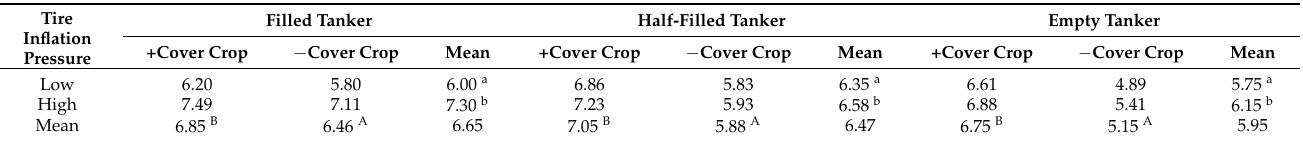
Table 3. Tire track depth (cm) affected by tire inflation pressure, filling level of slurry tanker (filled, half-filled and empty), and ground covering (+cover crop, − cover crop). Tire